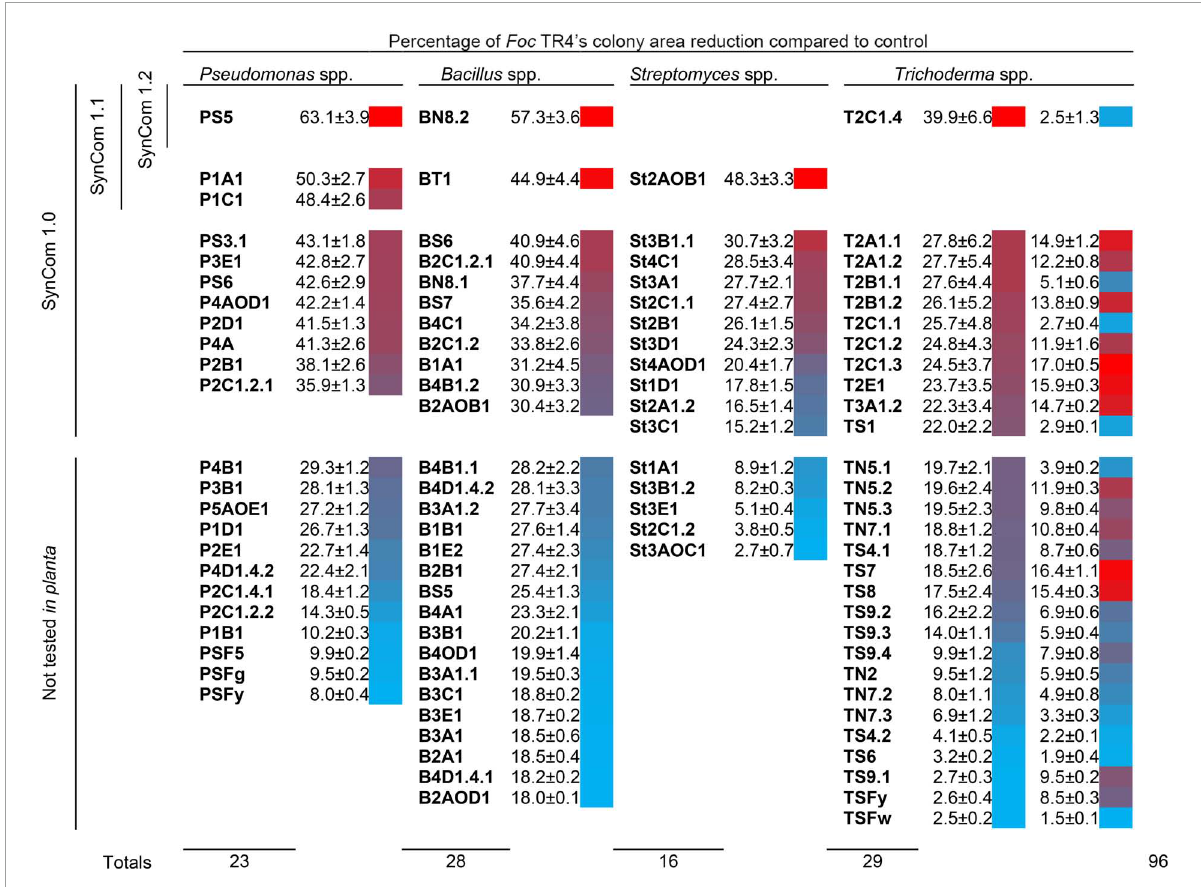
FIGURE2 Antagonistic activity of 96 microbial isolates obtained from the banana rhizosphere against Fusarium oxysporum f. sp. cubense ( Foc ) tropical race 4 (TR4). Means of four replicates, standard error, and heatmap are shown. Data for Pseudomonas spp., Bacillus spp., and Streptomyces spp. were obtained from dual culture assays (which allow evaluating the effect of both agar-diffusible metabolites and volatile compounds), and those for Trichoderma spp. from cellophane-agar (first column; only agar-diffusible metabolites) and overlapping plate methods (second column; only volatile compounds). Isolates included in the synthetic microbial communities SynCom 1.0, 1.1, and 1.2 are also